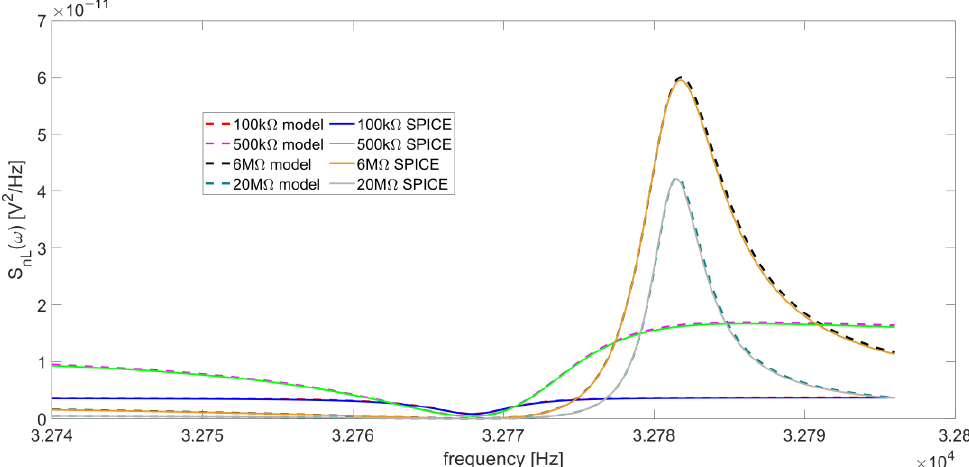
Figure 9. Comparison between SPICE simulations and analytical model described in Equation (7) of the output noise spectral density contribution from the thermal noise of R L , for four different values of the resistor: 100 kΩ, 500 kΩ, 6 MΩ , and 20 MΩ.